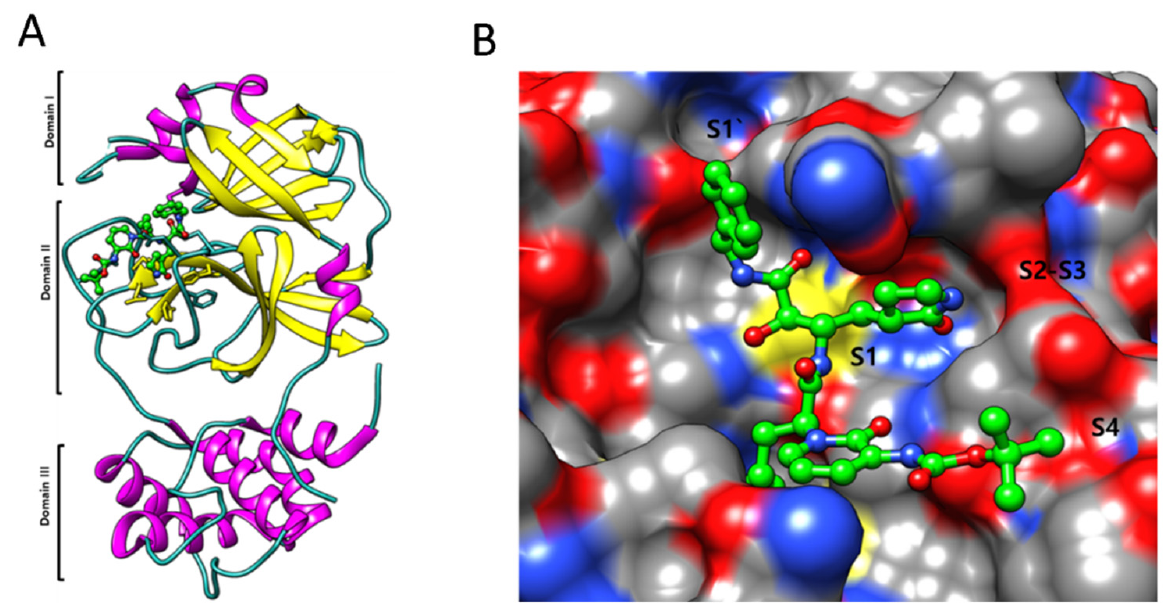
Figure 5. ( A ) The major protease of the SARS-CoV-2 monomer has three domains and is structurally unique. A linker connects Domains II and III, which is necessary for protein dimerization. ( B ) Subsite groups in the substrate-binding subsites of SARS-CoV-2 MPro: S1 ′ , S1, S2, S3, and S4.